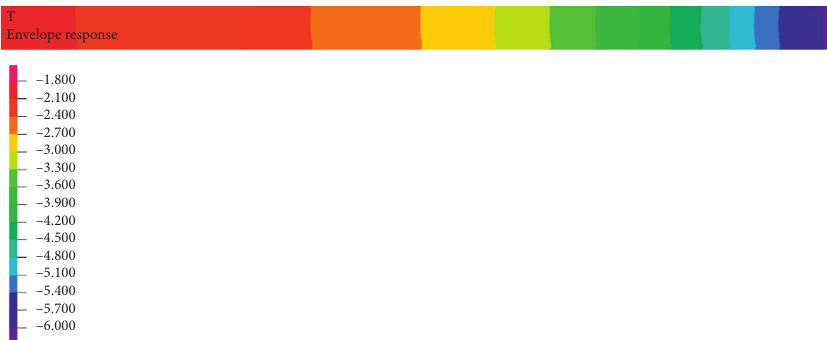
Figure 27: Annual average air temperature distribution in the tunnel axis at a depth of 50